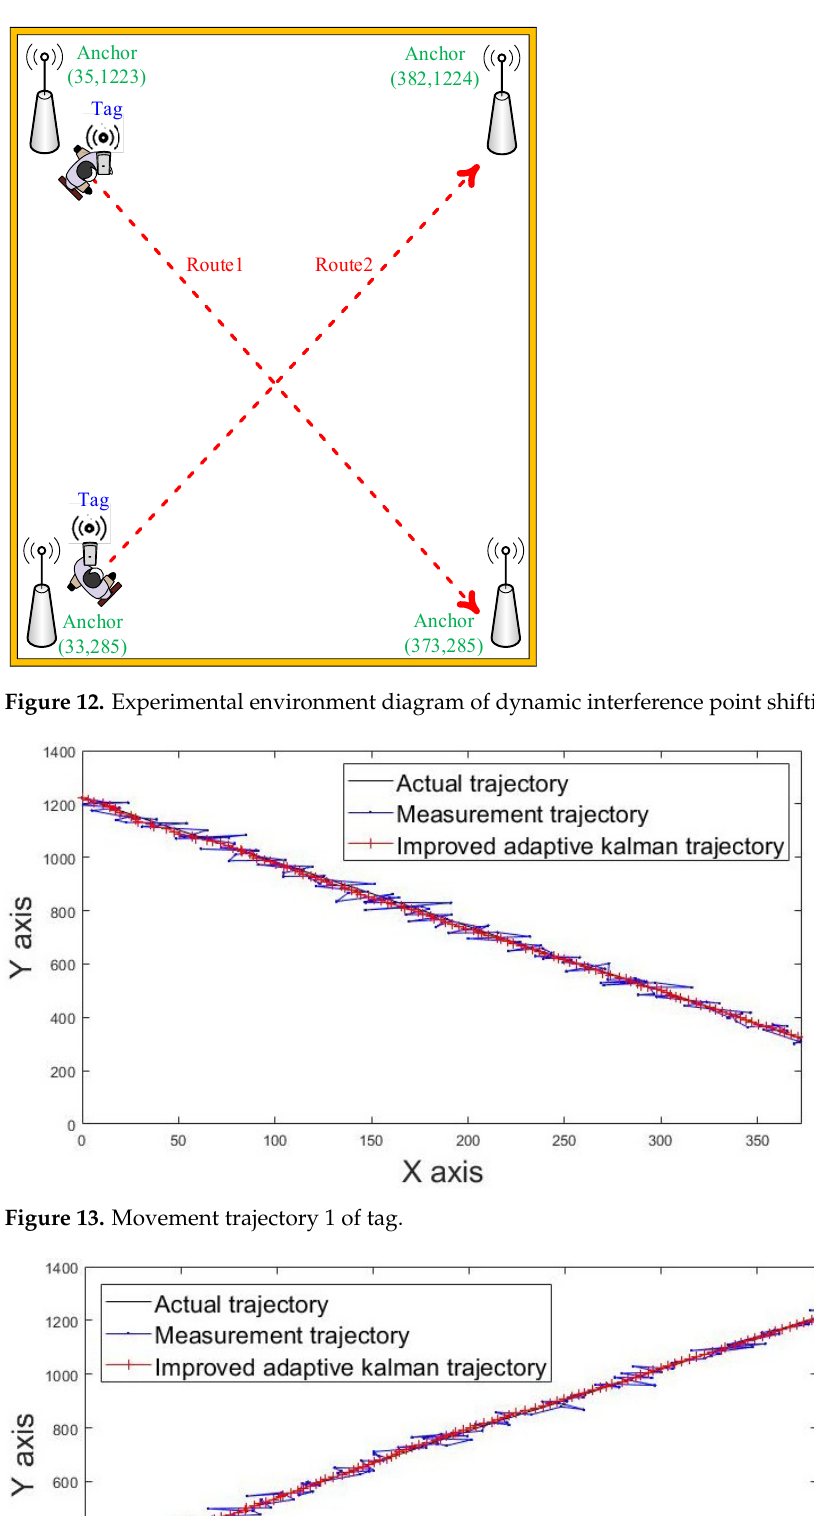
Figure 13. Movement trajectory 1 of tag.